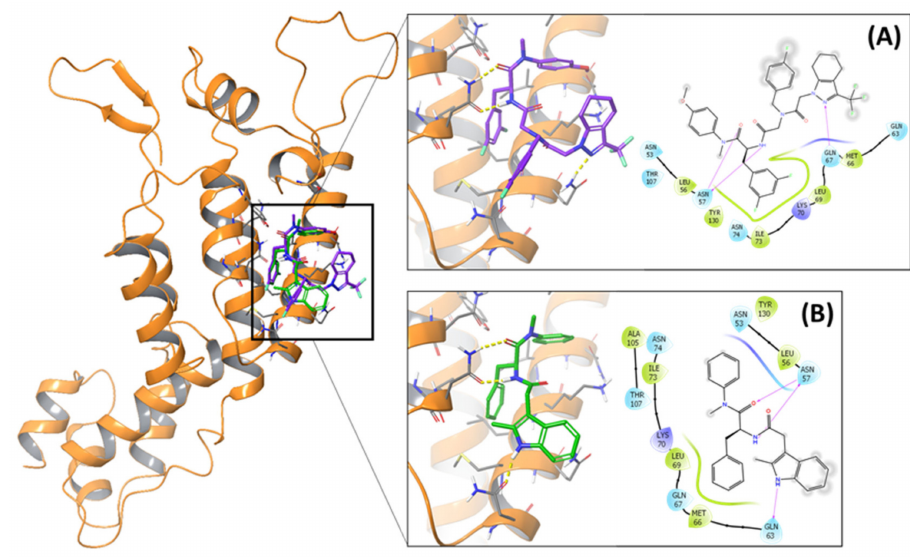
Figure 4. Ligand interaction to binding-site residues of capsid protein, ( A ) I-19 -5TSX complex, ( B ) PF-74 -5TSX complex.